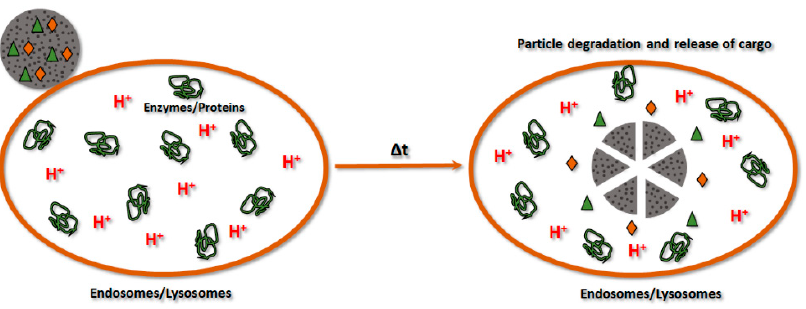
Figure 8. Schematic illustration of calcium phosphate particle degradation inside endosomal/lysosomal compartment (endosomal/lysosomal compartments are in orange color, enzymes/proteins are in green color, spherical calcium phosphate particle is in grey color, delivered cargoes are orange rhombs and green triangles).